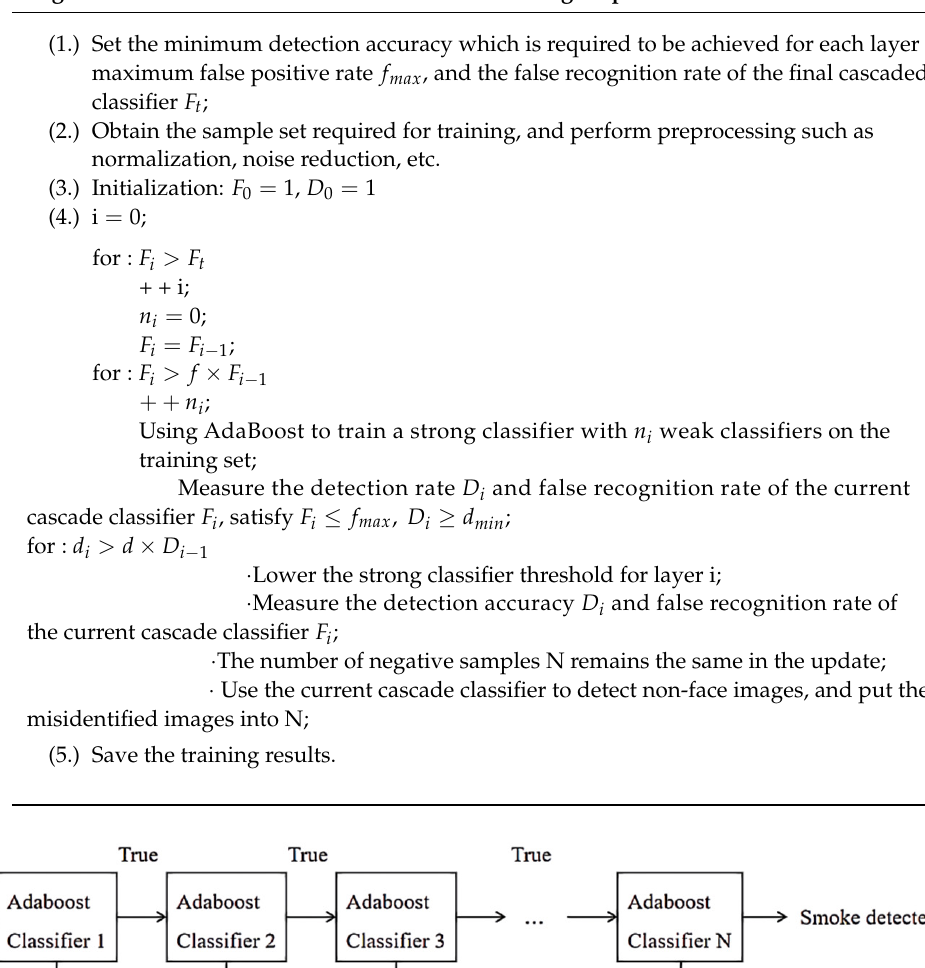
Algorithm 1 The Detailed Cascade Classifier Training Steps